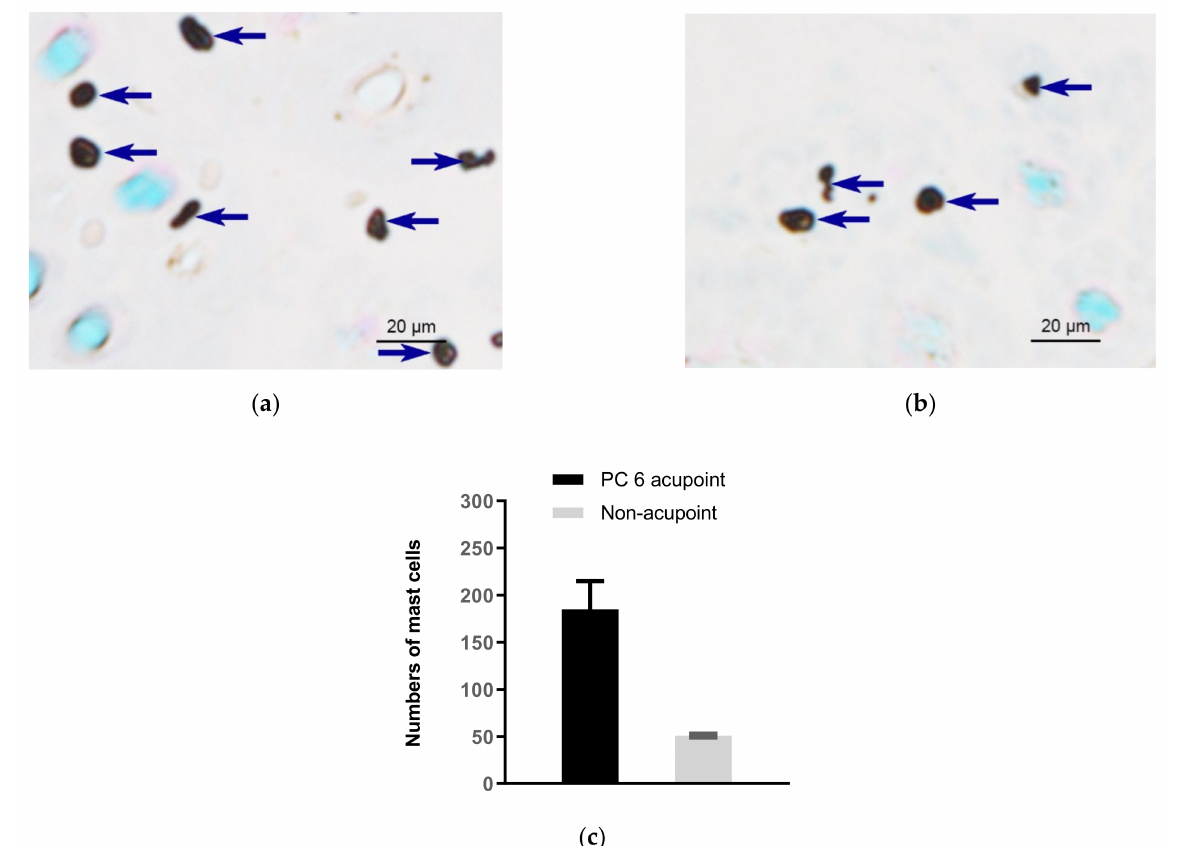
Figure 1. Comparison of subcutaneous MC density in acupoints and non-acupoints of normal rabbits. ( a,b ) Paraffin sections prepared from PC6 acupoints and non-acupoints, respectively. MCs were labeled with toluidine blue and shown as dark spots. Dark blue arrows indicate MCs. ( c ) Numbers of MCs in PC6 and the non-acupoint. Data represent means + SEM ( n = 3), and are based on Zhu et al. (2017) [17], with permission from Springer